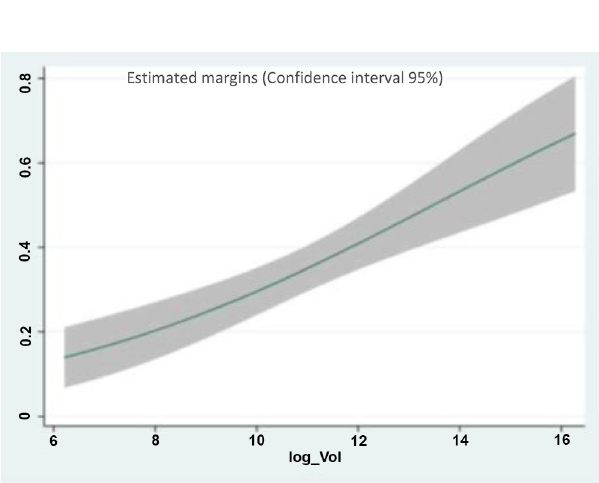
Figure 2. Probability to renew